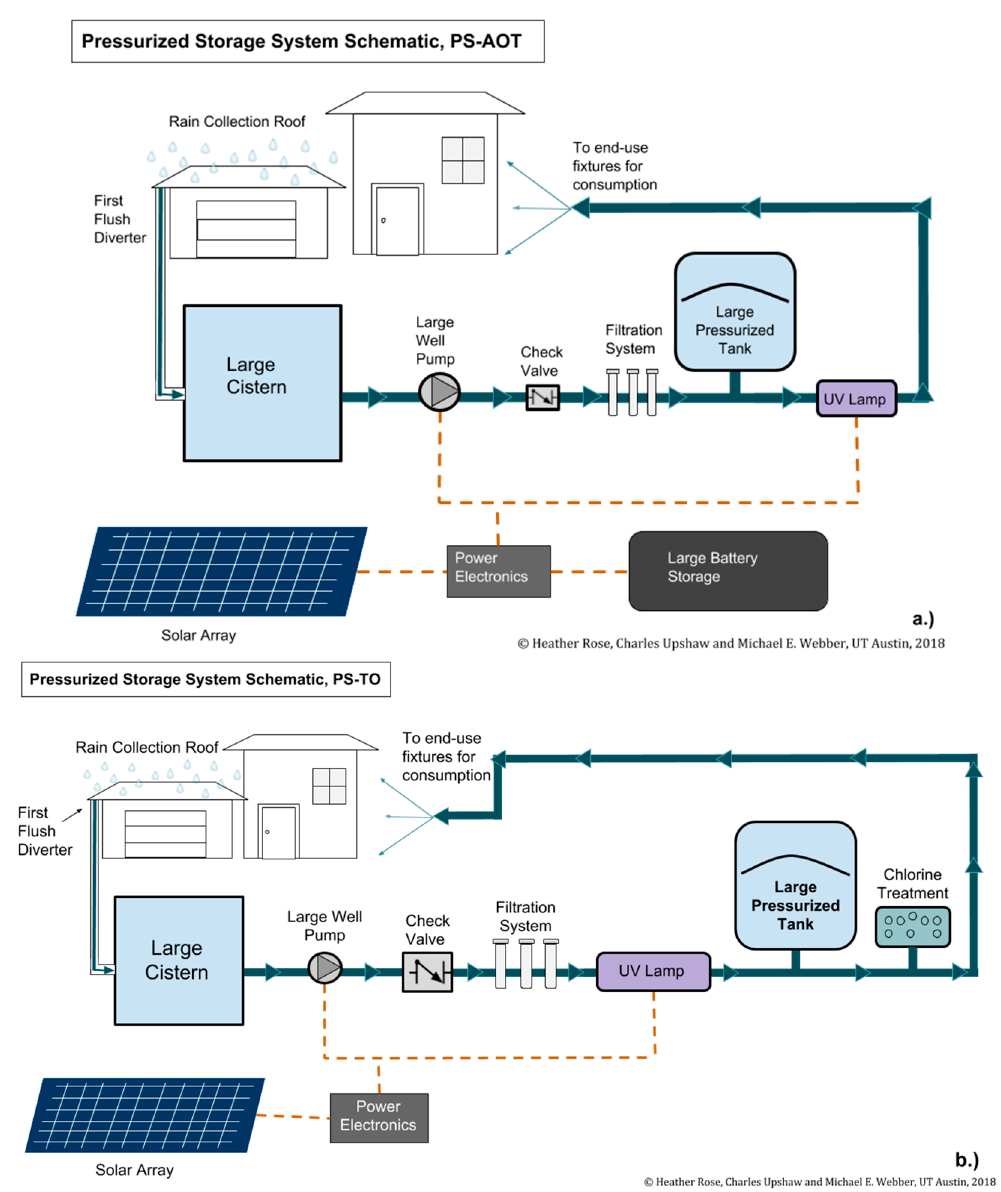
Figure 2. ( a ) PS-AOT System. In this system, water is stored in a large pressurized tank with the UV lamp located at the disposal end of the tank for on-demand treatment; ( b ) PS-TO System. In this system, water is pumped and treated simultaneously during daylight hours. Chlorine treatment is added to sterilize residual water before it goes to a fixture for